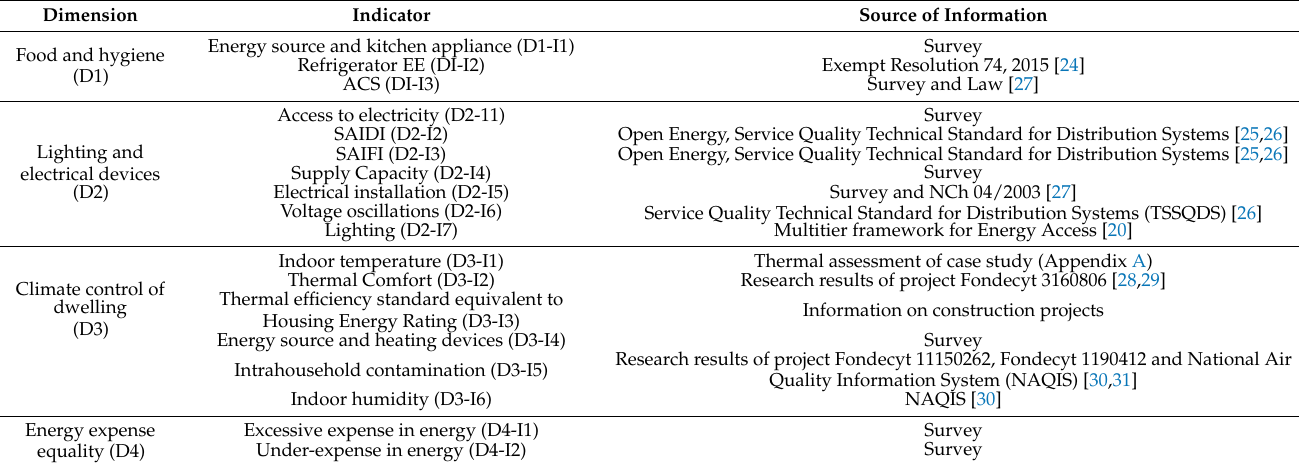
Table 4. Sources of information for the revision and application of